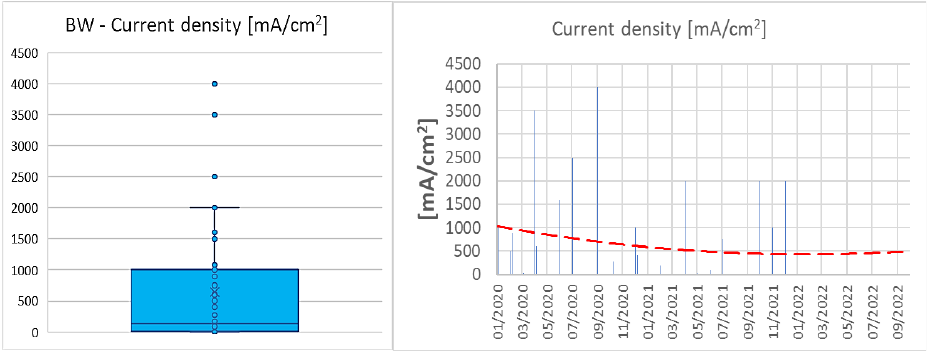
Figure 6. Graphic representation of the current density of the electrodes [10 – 13,41,47,57 – 60,62,63,76,77,79,81,89,90,94,98,101,108,115 – 117,119,120,123,126,127,129 – 132,134 – 144].